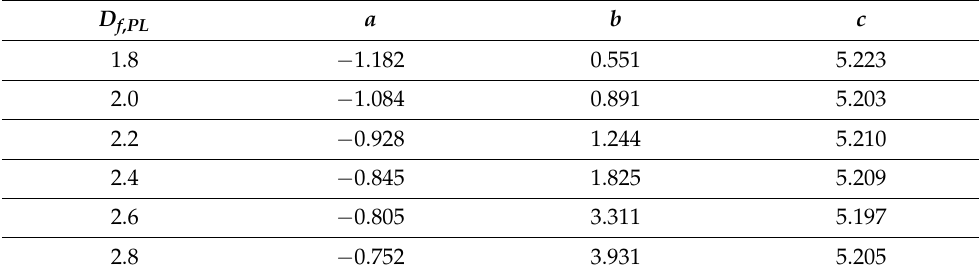
Table 6. Fitted values of a , b , and c corresponding to different D f , PL